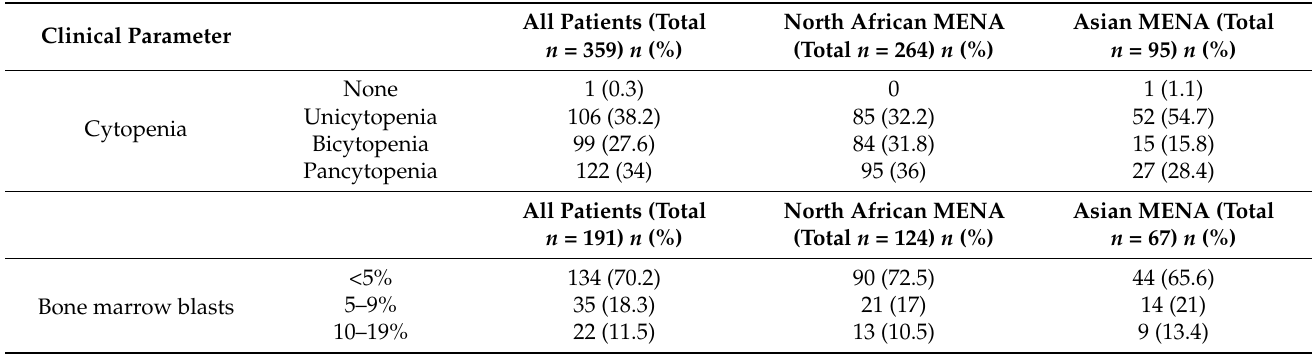
Table 3. Cytopenia and bone marrow blast values at